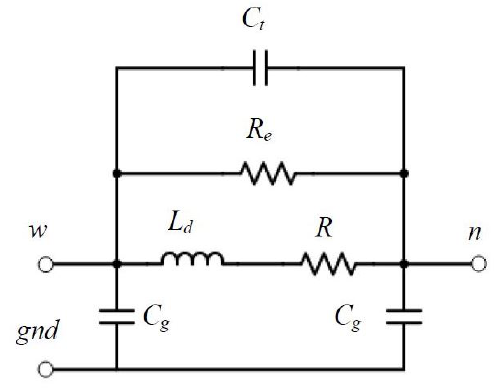
Figure 12. HF phase circuit proposed in [71].